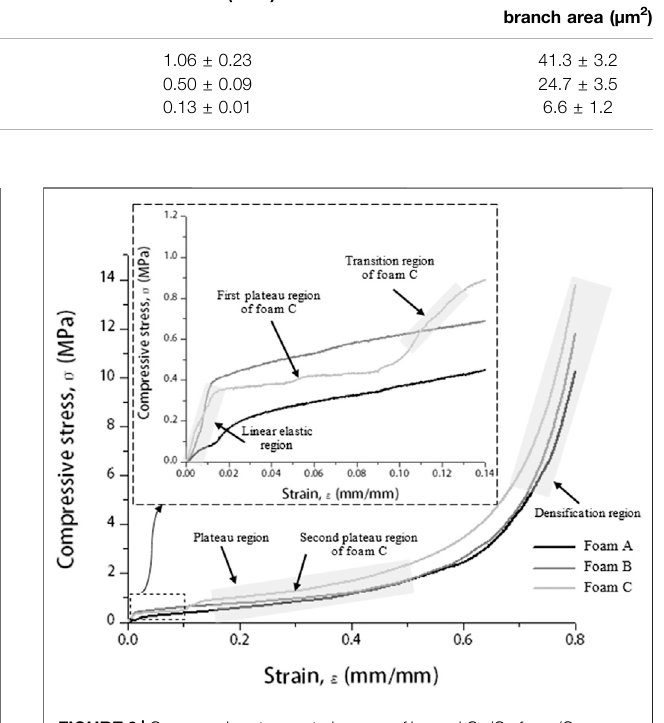
FIGURE 2 | Compressive strength of nonbrazed and brazed Cu/Cu foam/Cu using amorphous fi ller with different Cu foam pore densities and brazing temperature.